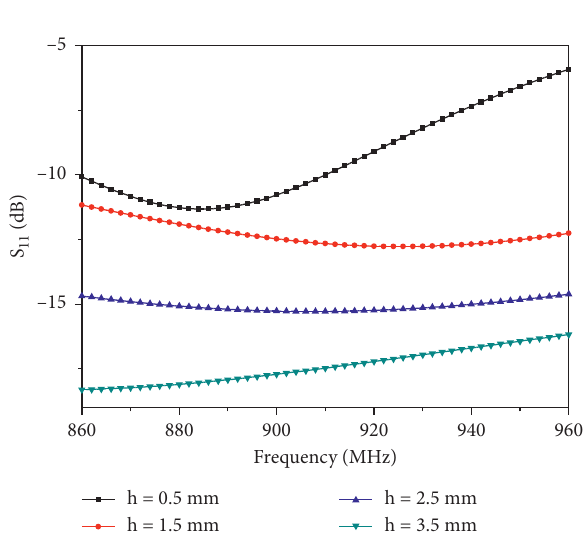
Figure 12: Simulated reflection coefficients of the three-branch antenna with different substrate